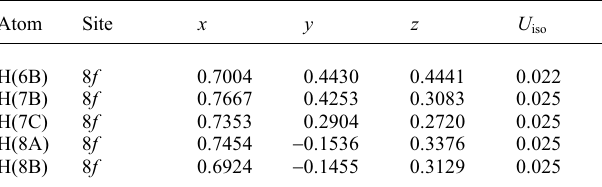
Table 3. Atomic coordinates and displacement parameters (in Å 2 )